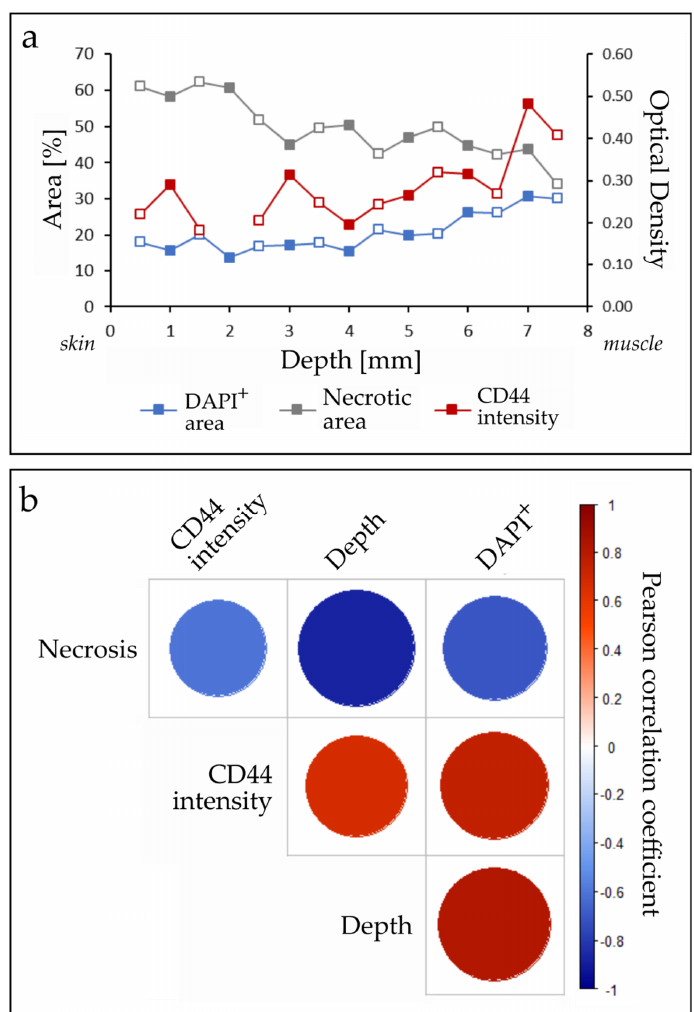
Figure 4. Cell composition of tumor slices along the depth of the tissue. Cancer stem cells (CD44 + ), cell numbers (DAPI + ), and the necrotic area were analyzed 24 h post irradiation with 4 Gy or control slices. Across the tumor a high variance was noted, showing that the morphology depends on the depth within the tissue. ( a ) Marker distribution across the tumor depth: locations further away from the nutrient-providing blood vessels in the muscle show a reduced cell number and an increased necrotic area. An inter-slice variability was noted, but no significant difference between the experimental conditions (full dots: control slices, open dots: irradiated slices). ( b ) Pearson correlation of tumor morphology. Significant positive and negative correlations were found between all markers (see text, n Control = 7, n Tumor = 8).